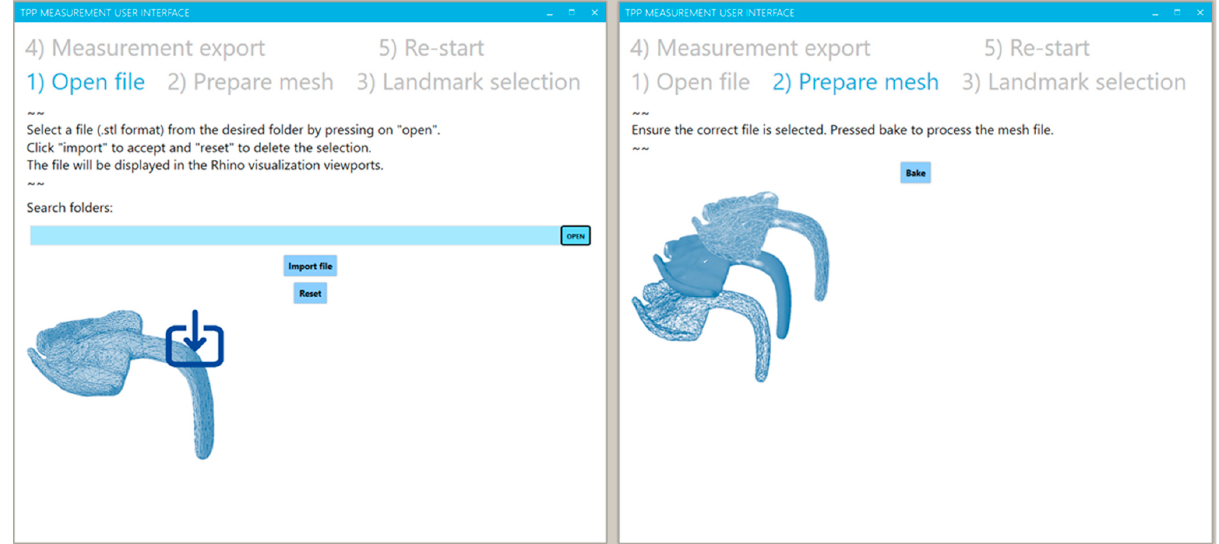
Figure 14. User interface view for the tabs of “open file” ( left ) and “prepare mesh” ( right ). Later, the landmarks for the measurement basis and orientation were placed by the user. For that, the user was required to activate the landmark selection in the UI and sub- sequently select the appropriate vertices or point related to the landmark (Figure 15). The selection was carried out in the main Rhino visualization window, where the selected point would turn green. The selected point could be eliminated and the selection process carried out again by the button “eliminate”. Moreover, the user could activate a control window by the “selection control” button, which allowed a feedback about the complete- ness of the selection procedure and identifying which point selection was missing. This control step was important to establish, as the measurement could only be executed by selecting four landmarks. Once the selection was completed, all points, lines, planes, etc. needed for the measurement were automatically created. In the tab “measurement export”, the user could define a file name and a folder for export. By selecting the “export” button, all measured values will be exported into a .csv document. In case any landmark has been eliminated or the measuring process has not been activated, the program will execute an error window (Figure 16) informing about the export of an empty document. Finally, the user could activate the button in the re-start tab (Figure 16), and all of the performed changes and processes can then be eliminated, setting the program to default mode. The user can re-start the process with a new measuring file in the first tab. For more detailed insight into the functioning of the proposed program, see the supplementary data.